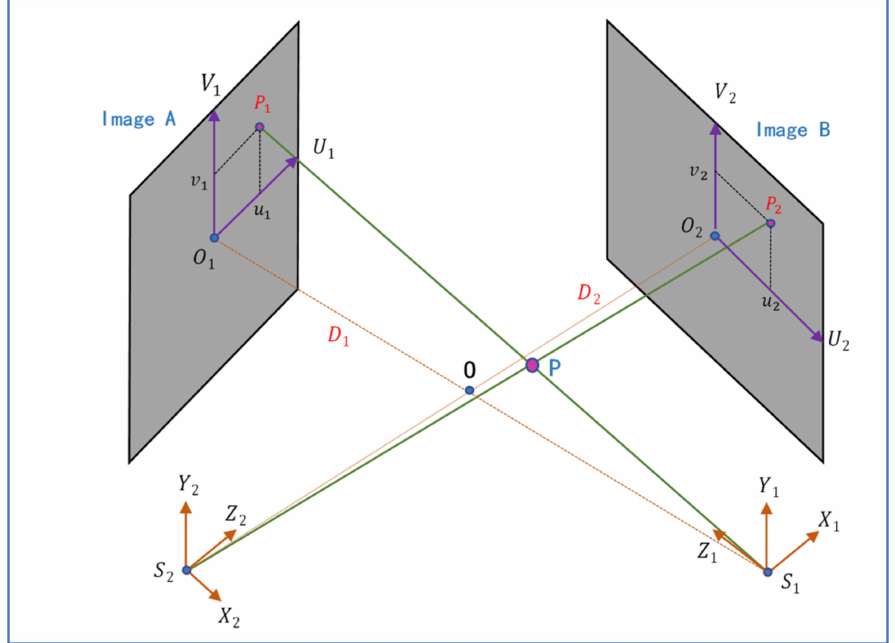
Figure 1. The geometric relationship between two coronary angiography